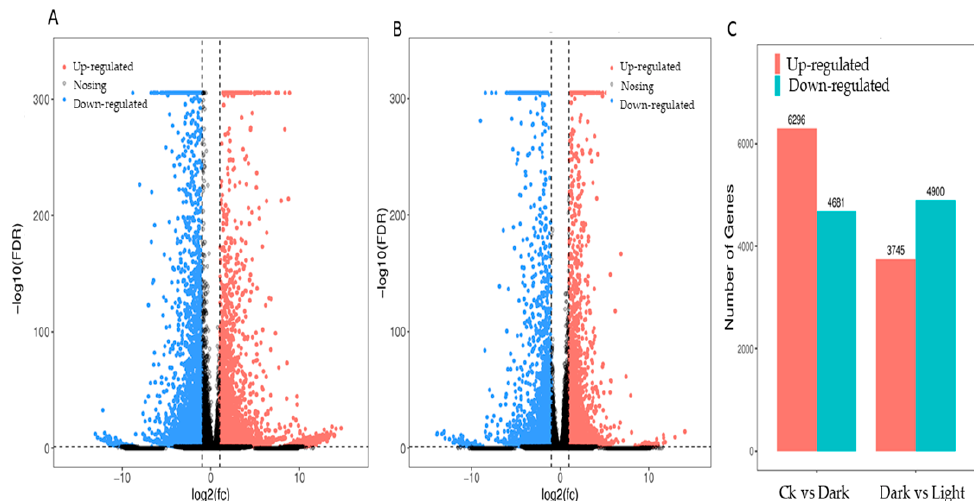
Figure 3. DEG statistics under controlled light and darkness conditions in M. canadensis transcriptomes. ( A ) Volcano plots of total DEGs in the leaves’ expression profiles after 24 h of darkness treatment. ( B ) Volcano plots of total DEGs in the leaves after 24 h of light exposure. ( C ) Total DEGs in the leaves’ expression profiles after darkness treatment and light exposure.